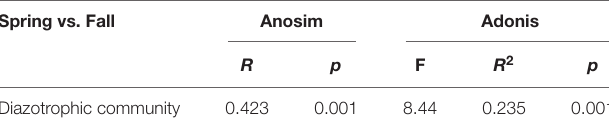
TABLE 3 | Dissimilarity comparison of the soil diazotrophic community structure between the spring and fall cropping seasons. Spring vs.